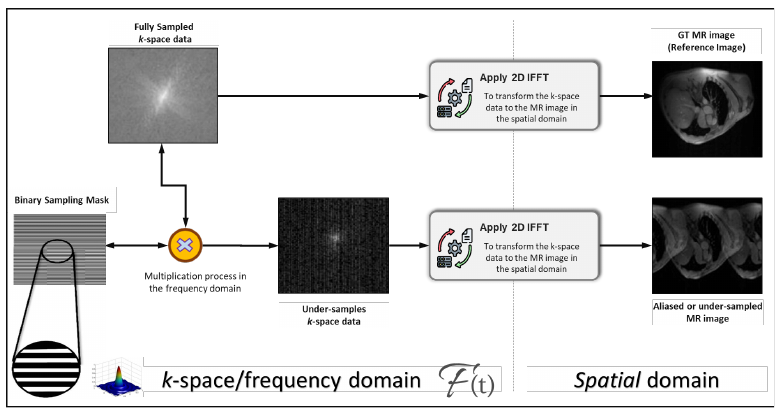
Figure 1. The proposed AI-based MRI reconstruction framework.